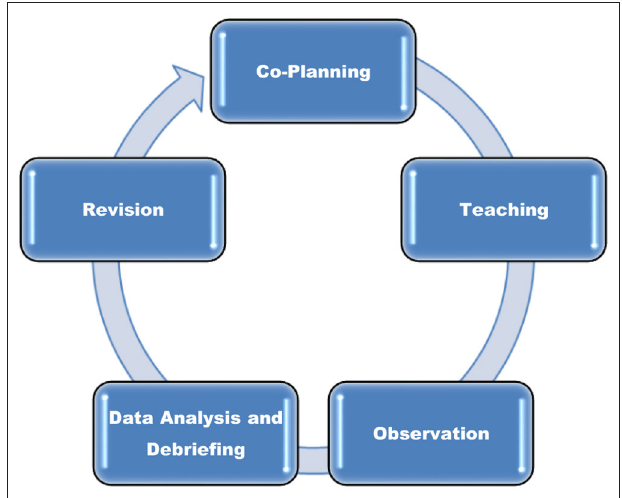
FIGURE 3 | Didactic cycle of the Lesson